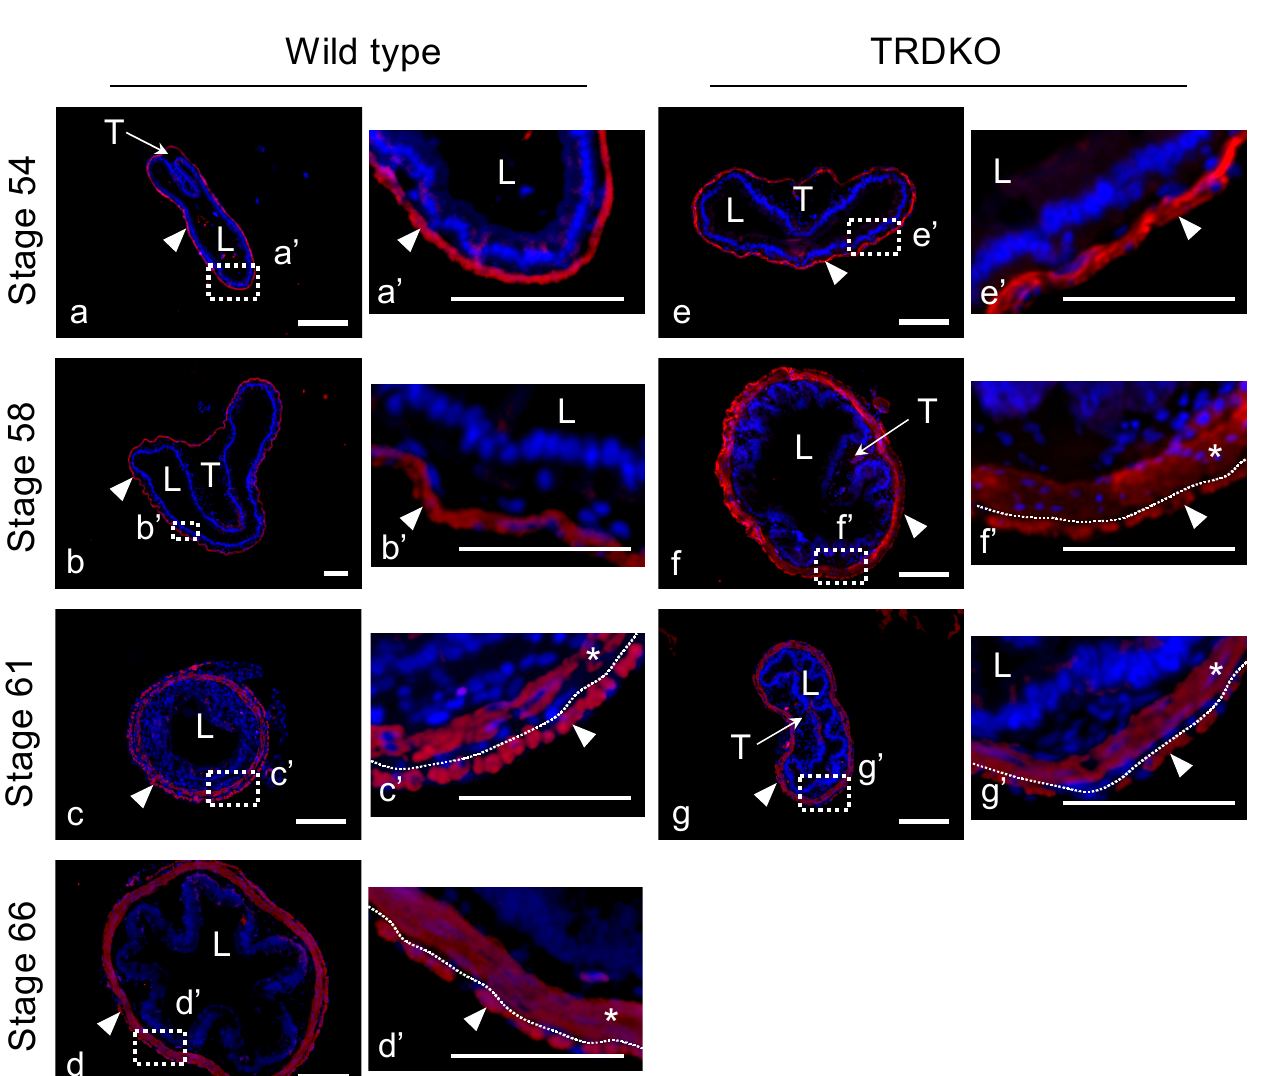
Figure 4. TRDKO accelerates intestinal muscle development during metamorphosis. Cross-sections of the intestine isolated